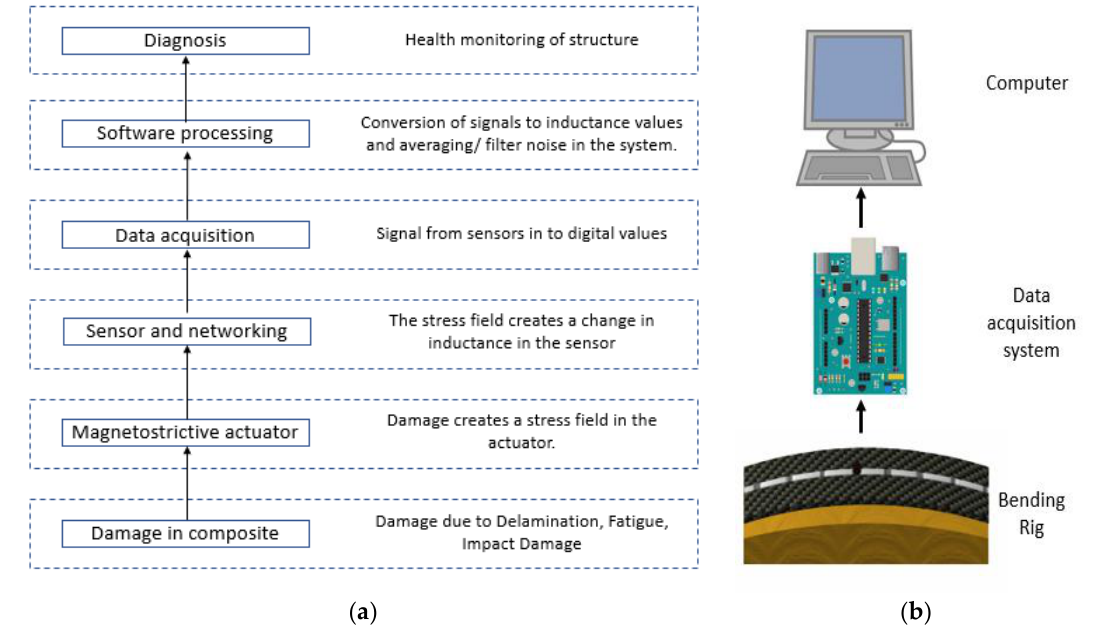
Figure 6. ( a ) Functional block diagram of the system ( b ) Experimental setup for bending rig test.